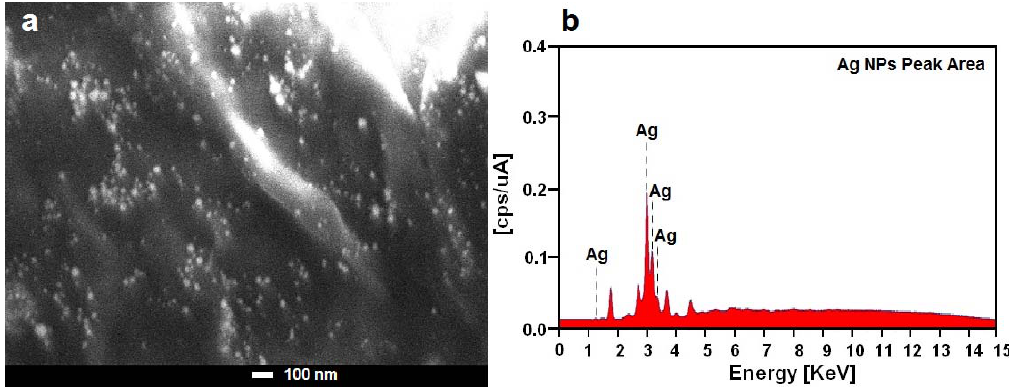
Figure 5. SEM image and EDXRF spectrum of Ag-NPs formed in Callicarpa maingayi Stem bark extraction after 48